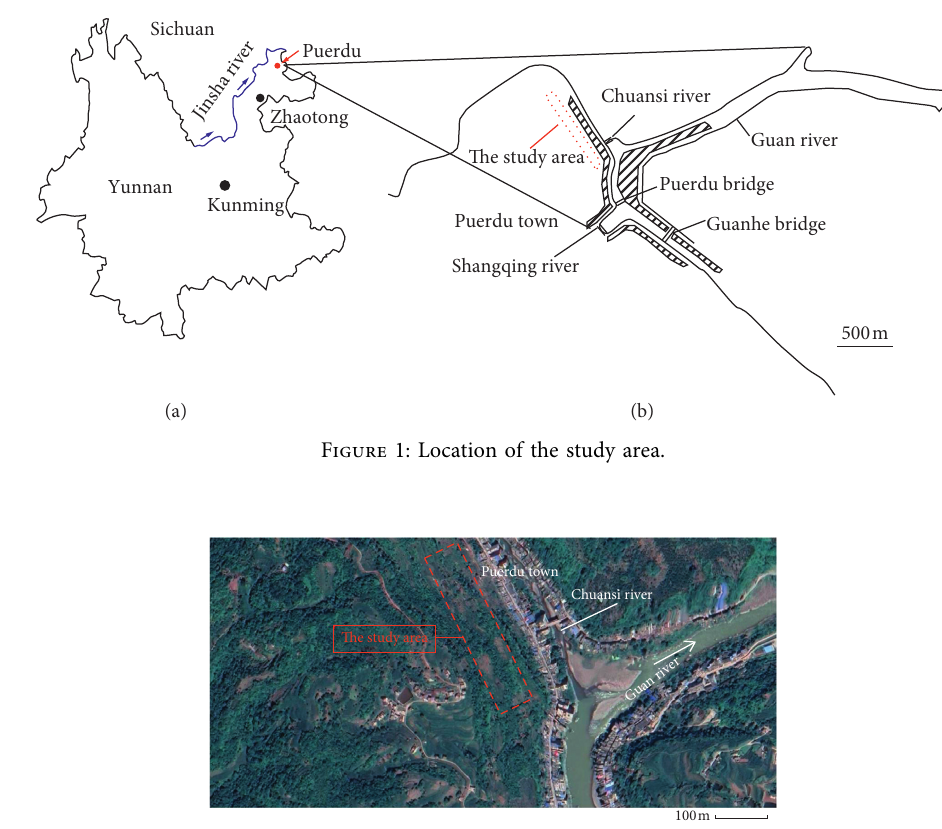
Figure 2: Location of the study area (satellite